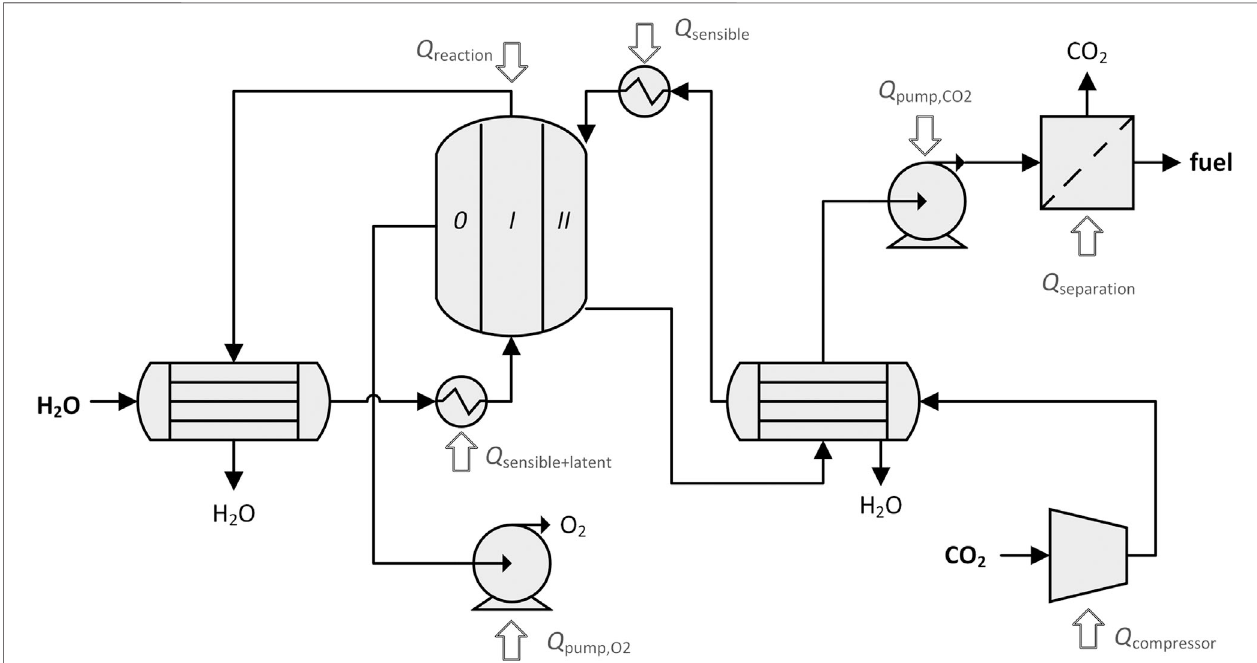
FIGURE 3 | Process diagram of the dual-membrane reactor including process units and heat inputs. Different subsets of these process units are applicable for different membrane con fi gurations and operating conditions.